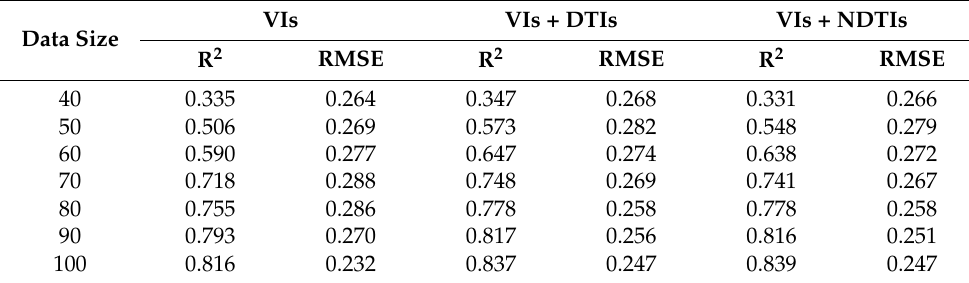
Table 9. The LAI estimation results of PCA_ST + SVR models with sample sets of different